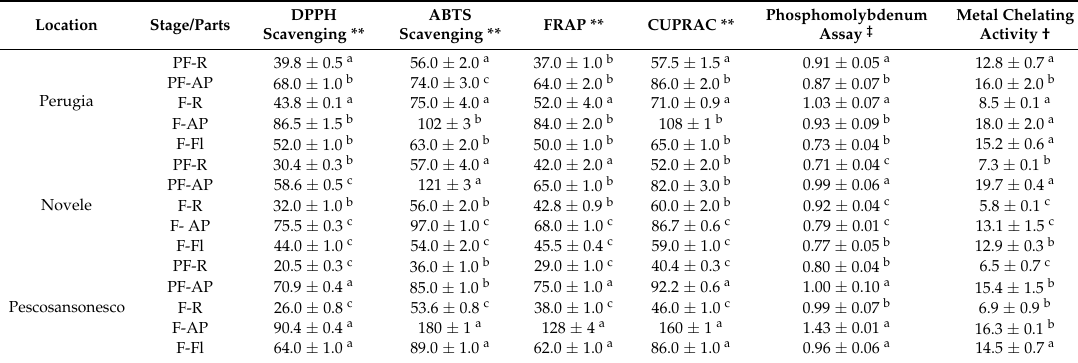
Table 5. Antioxidant evaluation and metal chelating activity of different parts of A. lutea collected from three different locations in Italy *.